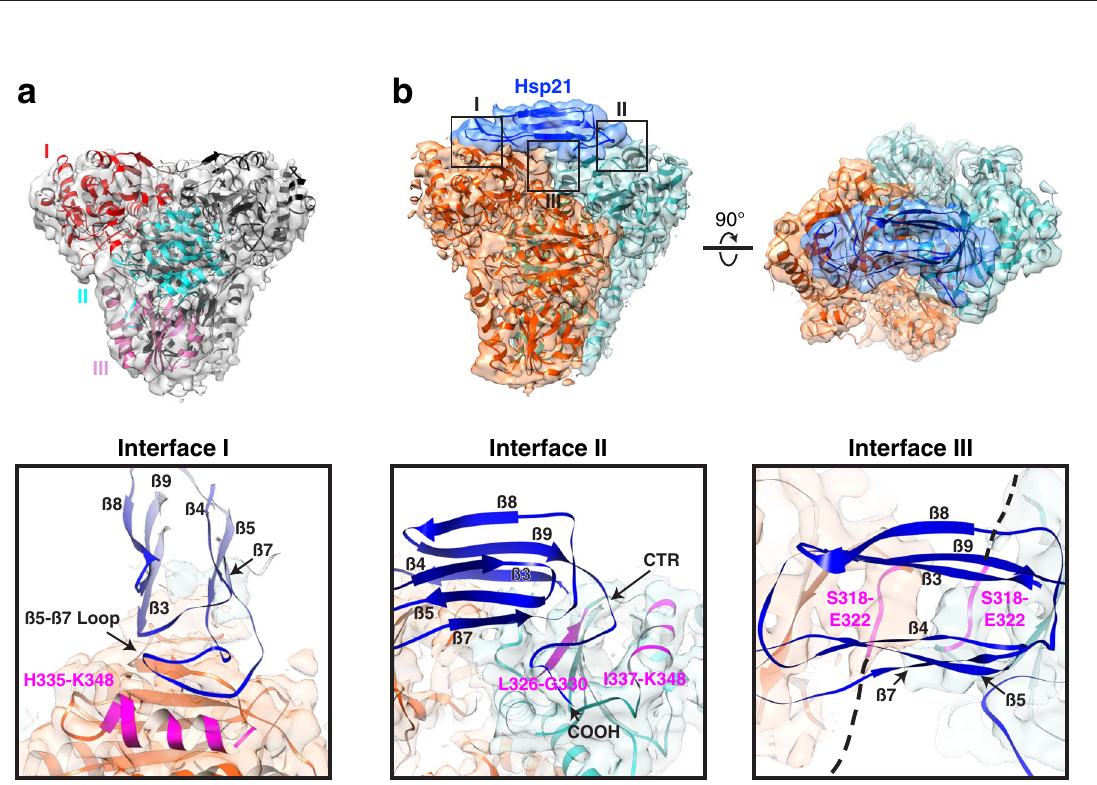
Fig. 2 Structures of DXPS and Hsp21-DXPS. a Cryo-EM map of DXPS with the fi tted model. The three domains of one subunit of the DXPS dimer are indicated with labels and represented by different color. The other subunit of the dimer is shown in black. b Composite cryo-EM map of Hsp21-DXPS with fi tted models. The two subunits of the DXPS dimer are shown in orange and sea green and Hsp21 is shown in blue. The three identi fi ed interaction interfaces (I, II, and III) are indicated (black boxes) with the corresponding zoomed-in views shown below. Interface III is viewed from the top of the complex. The putative interacting regions on domain I (for Interface I and II) and the mobile loops (for Interface III) of DXPS are highlighted in magenta. The dashed lines denote the disordered mobile loops with no map densities. All β strands and the C-terminus of Hsp21 are labeled. Here DXPS denotes DXPS-His-FLAG and Hsp21 denotes Hsp21-bound DXPS particles (Supplementary Fig. 2e), and the structures of free DXPS and the Hsp21-DXPS complex were determined to a global resolution of 4.0 Å and 3.7 Å, respectively (Supplementary Fig. 2f). The local resolutions vary greatly in both reconstructions, ranging from 3.9 to 5.4 Å and 3.6 to 5.1 Å for DXPS and the Hsp21-DXPS complexes, respectively, likely due to inherent fl exibility (Supplementary Fig. 2g). Focused classi fi cation and re fi nement did not improve the local densities, suggesting that the motions were continuous. To facilitate model building, an optimized local sharpening approach was employed to increase the interpretability of the maps 41 .